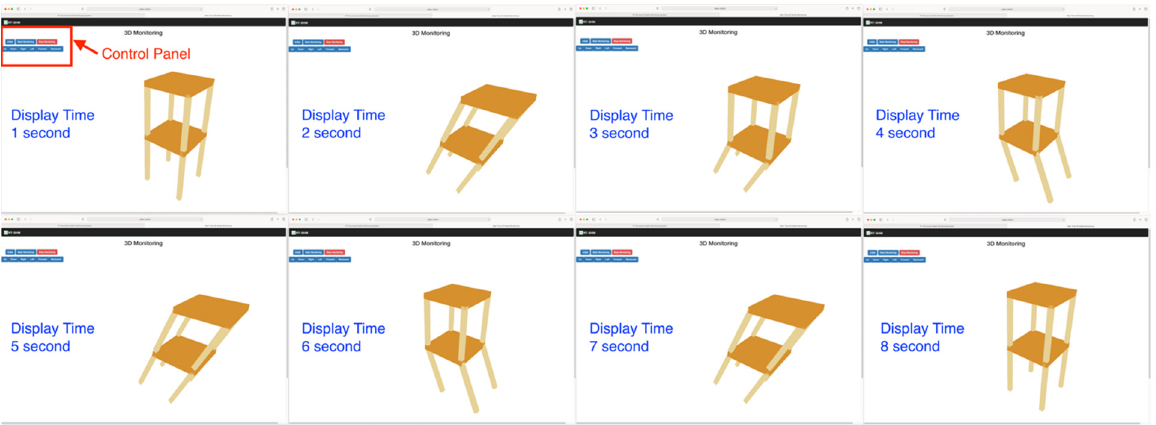
Figure 17. Two-story model movements.